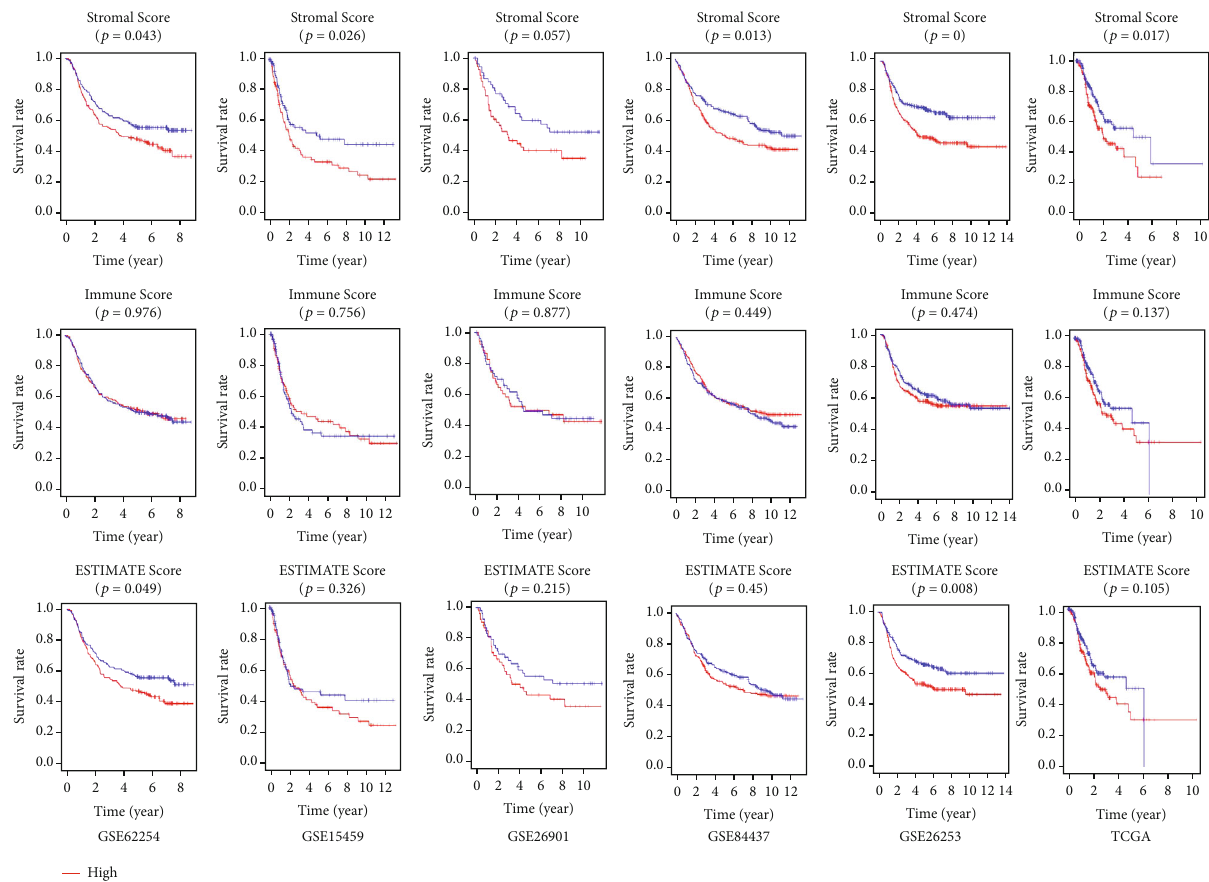
Figure 10: The Kaplan – Meier survival analysis of Stromal Score, Immune Score, and ESTIMATE Score in the six independent